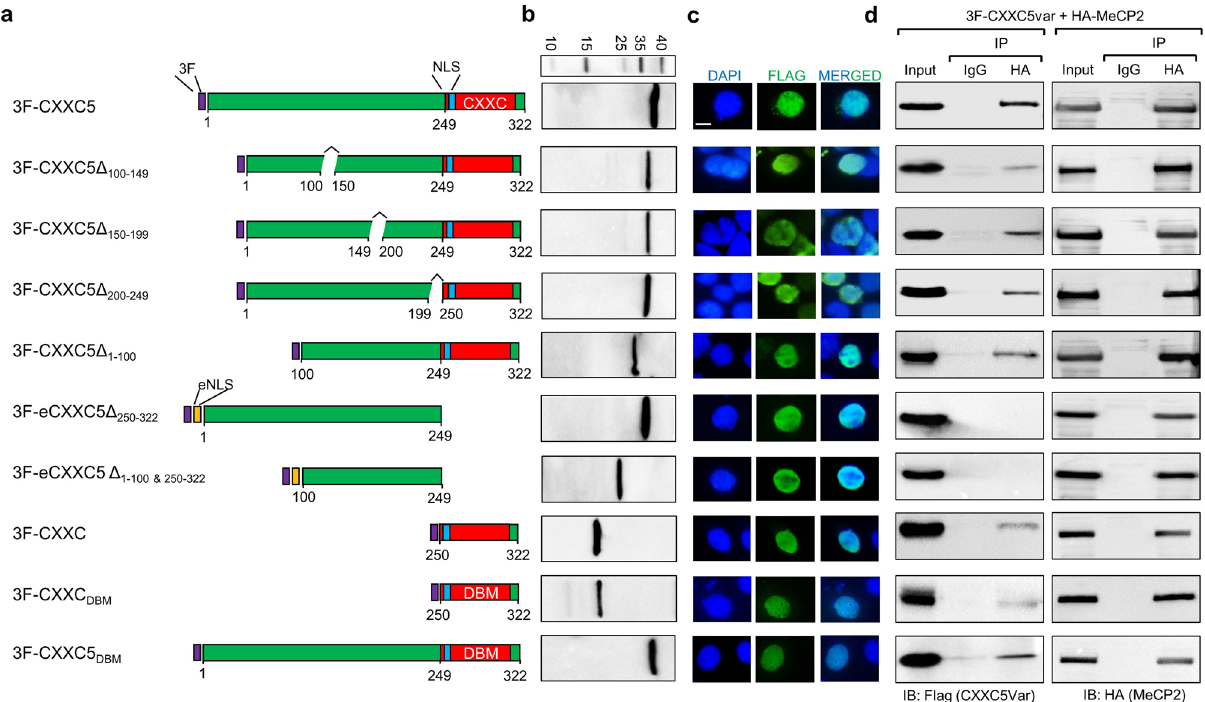
Figure 6. Identification of interaction region(s) of CXXC5 with MeCP2. ( a ) Schematics of CXXC5 variants. 3F denotes 3XFlag tag and eNLS is an NLS signal derived from the SV40 T antigen. DBM denotes DNA binding mutant. ( b ) The synthesis of proteins in transiently transfected HEK293 cells was verified by WB using the Flag antibody. Molecular masses (MM) in kDa are indicated. ( c ) Transiently transfected HEK293 cells were subjected to ICC using the Flag antibody followed by Alexa Fluor 488 conjugated secondary antibody for visualization with a fluorescence microscope. DAPI was used for the nuclei staining. ( d ) HEK293 cells were transiently co-transfected with the expression vector bearing cDNA for a 3F-CXXC5 variant and HA-MeCP2. Nuclear extracts (500 ug) were subjected to Co-IP with the HA antibody or the isotype-matched IgG. The precipitates were subjected to SDS-15%PAGE followed by WB using the Flag antibody or the HA antibody. 10% of nuclear extracts was used as input